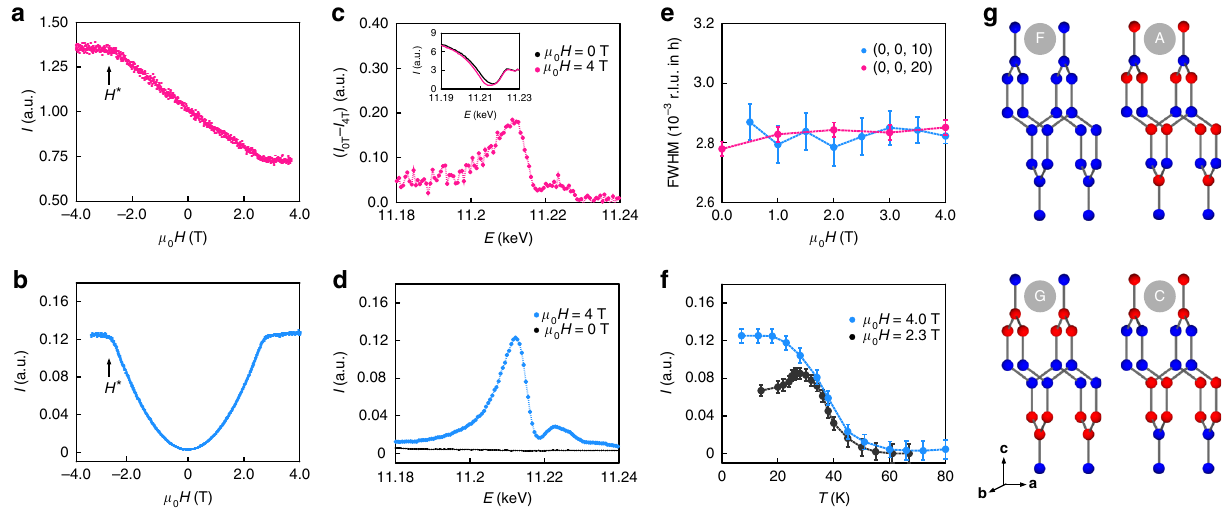
Fig. 3 Field, energy and temperature dependence of the commensurate order q = (0, 0, 0). Field dependence of the scattering intensity taken at T = 5 K and E = 11.215 keV around: a the structurally allowed (2 m , 0, 14 n + 2 m ) peaks (e.g. (0, 0, 20)) which show a linear dependence and, b the symmetry disallowed peaks (2 m , 0, 12 n ± 2 + 6 m ) (e.g., (0, 0, 10)) which show a quadratic dependence to the applied fi eld. A kink was again observed at μ 0 H * = 2.8 T. The energy dependence for the allowed peaks is shown in the inset c with a dip at the absoption edge E = 11.215 keV. The main panel c shows the difference between the intensity at μ 0 H = 0, 4 T which can be attributed to a magnetic contribution. d Energy dependence of the magnetic peak (2 m , 0, 12 n ± 2 + 6 m ) taken at μ 0 H = 0, 4 T. e (0, 0, 10) and (0, 0, 20) peaks widths (a lower bound on the correlation length) remain constant under the applied fi eld, suggesting there is no macroscopic phase separation. f Temperature dependence of the integrated intensities for the (0, 0, 10) at applied fi elds above and below H *. Above H * the onset of the FIZZ state is continuous, while below H * this onset is cut off by the incommensurate order. The Gaussian fi t to the integrated RMXS intensity gives the χ 2 uncertainty shown by the error bars in e , f . g Possible basis vectors describing the magnetic order of β -Li 2 IrO 3 , where F corresponds to ferromagnetic order, A to Néel order, C to stripy order and G to zig-zag order